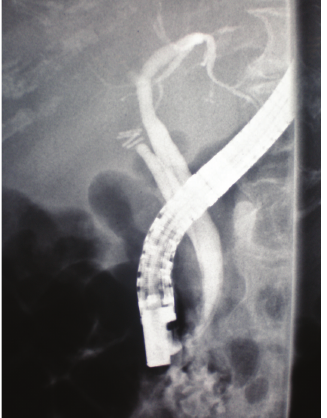
Figure 1: During the repeat ERCP a stent was placed in the terminal bile duct. Intrahepatic biliary ducts appear significantly narrowed.